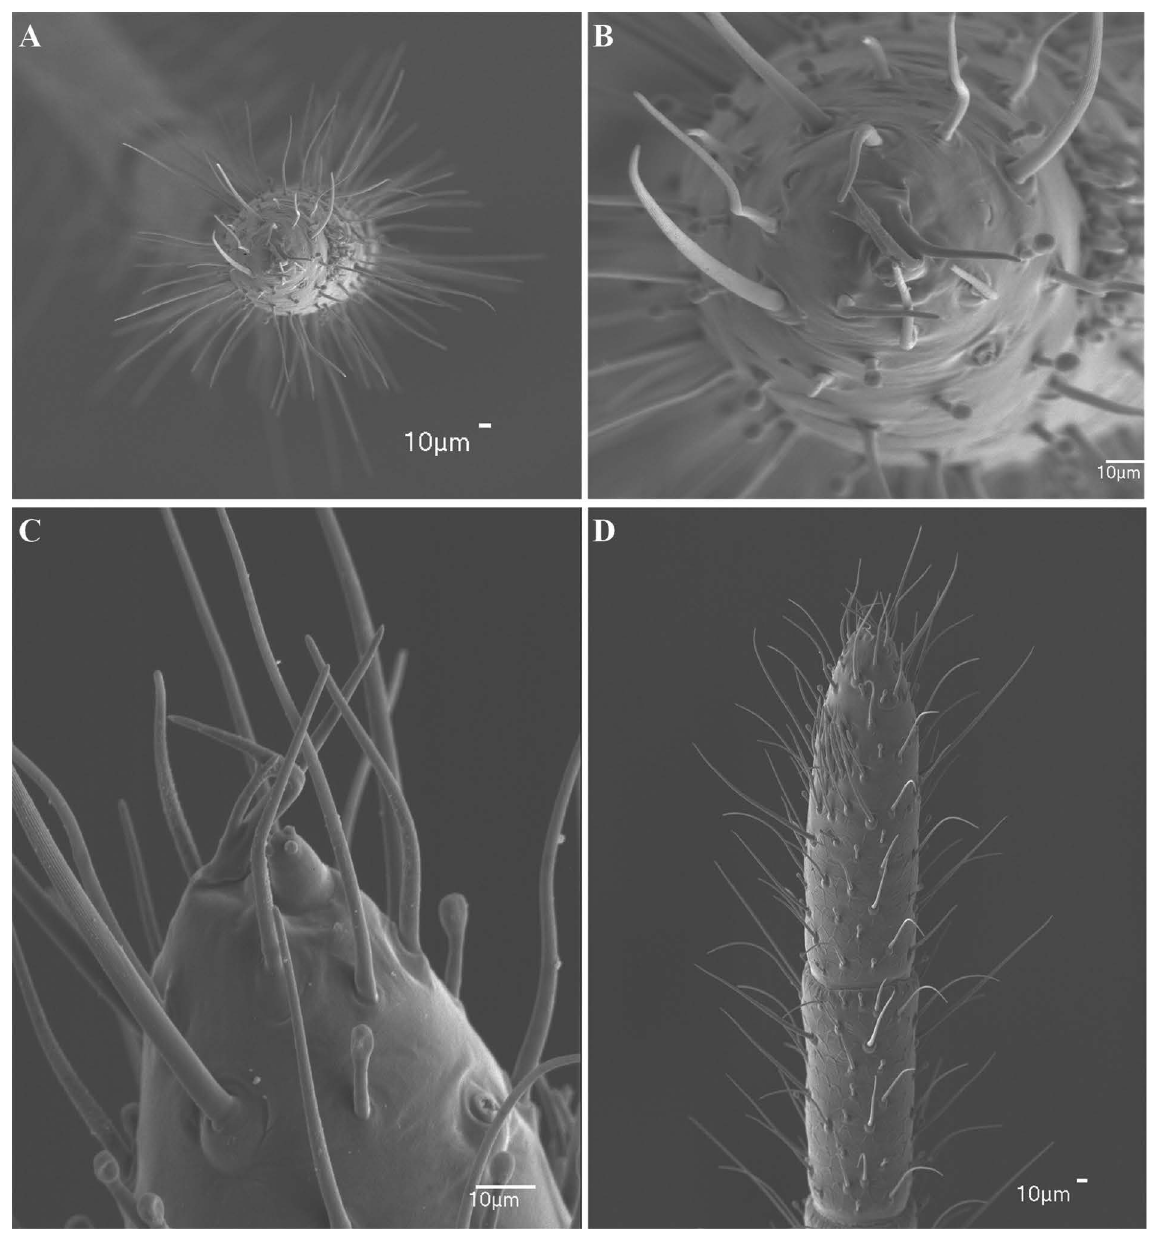
Fig. 60. Charinus diamantinus sp. nov. (MNRJ 9189), antenniform leg I, ♀. A . Frontal view. B . Apex showing claw. C . Claw and tarsal organ, lateral view. D . Rod sensilla lateral view.